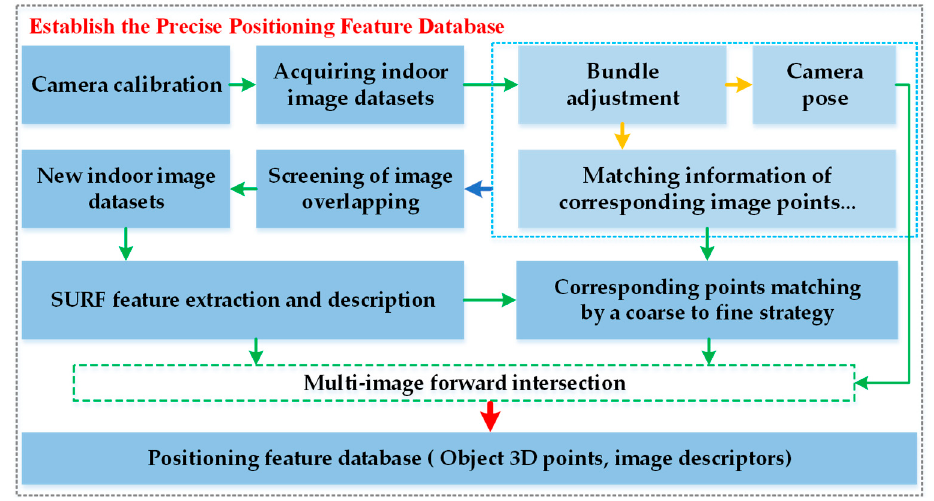
Figure 2. The workflow of the positioning feature database establishment.